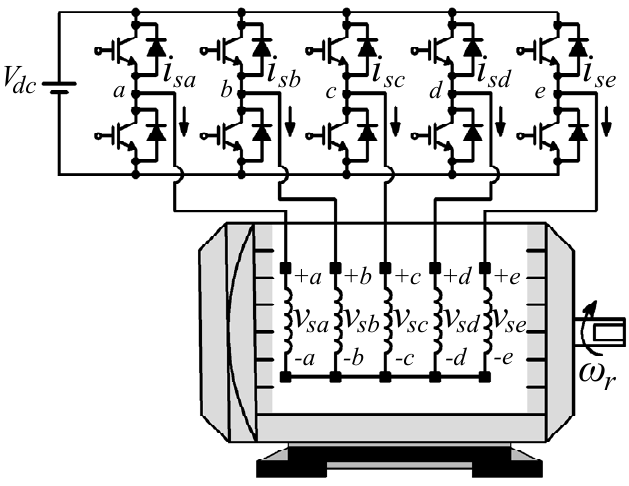
Figure 1. General scheme of the system under study.